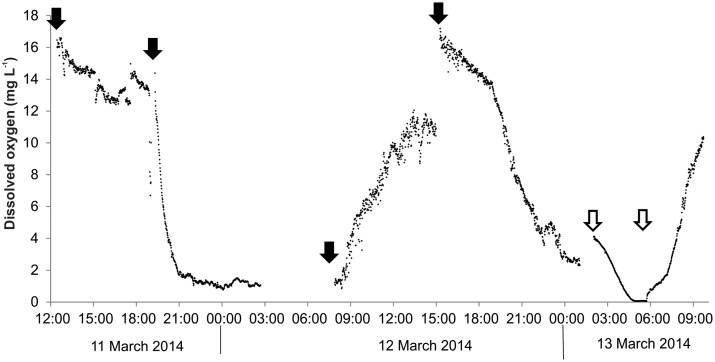
Temperature, dissolved oxygen concentration and pH mid-channel in the Mangatainoka River (site B, 11 March to 13 March 2014) measured using a water quality sonde (EXO2, YSI, USA) logging at 5-min intervals.